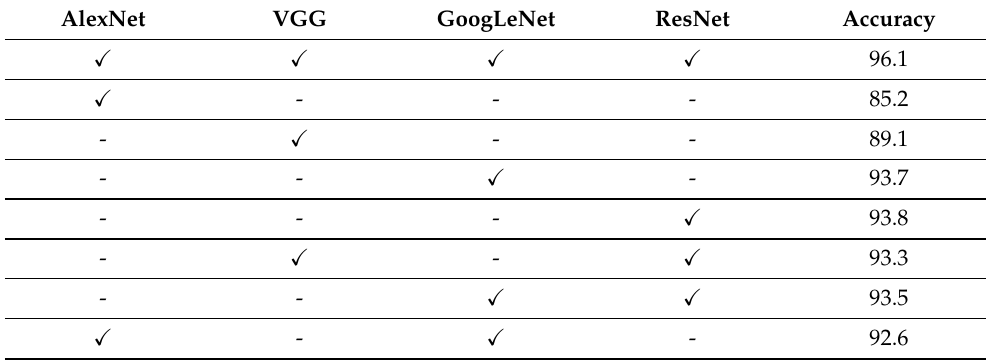
Table 7. Accuracy of different submodels.